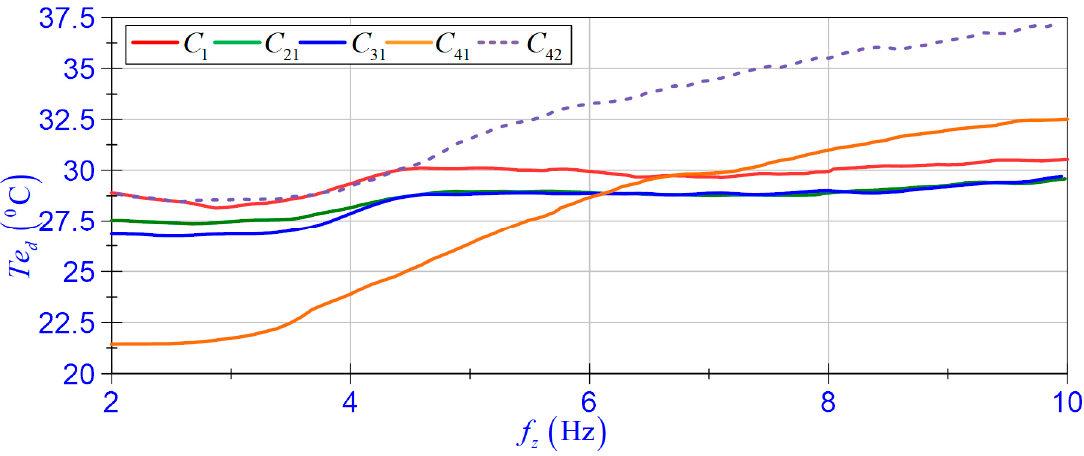
Figure 8. MR damper housing temperature 𝑇𝑒 (cid:3031) vs. frequency 𝑓 (cid:3053) .